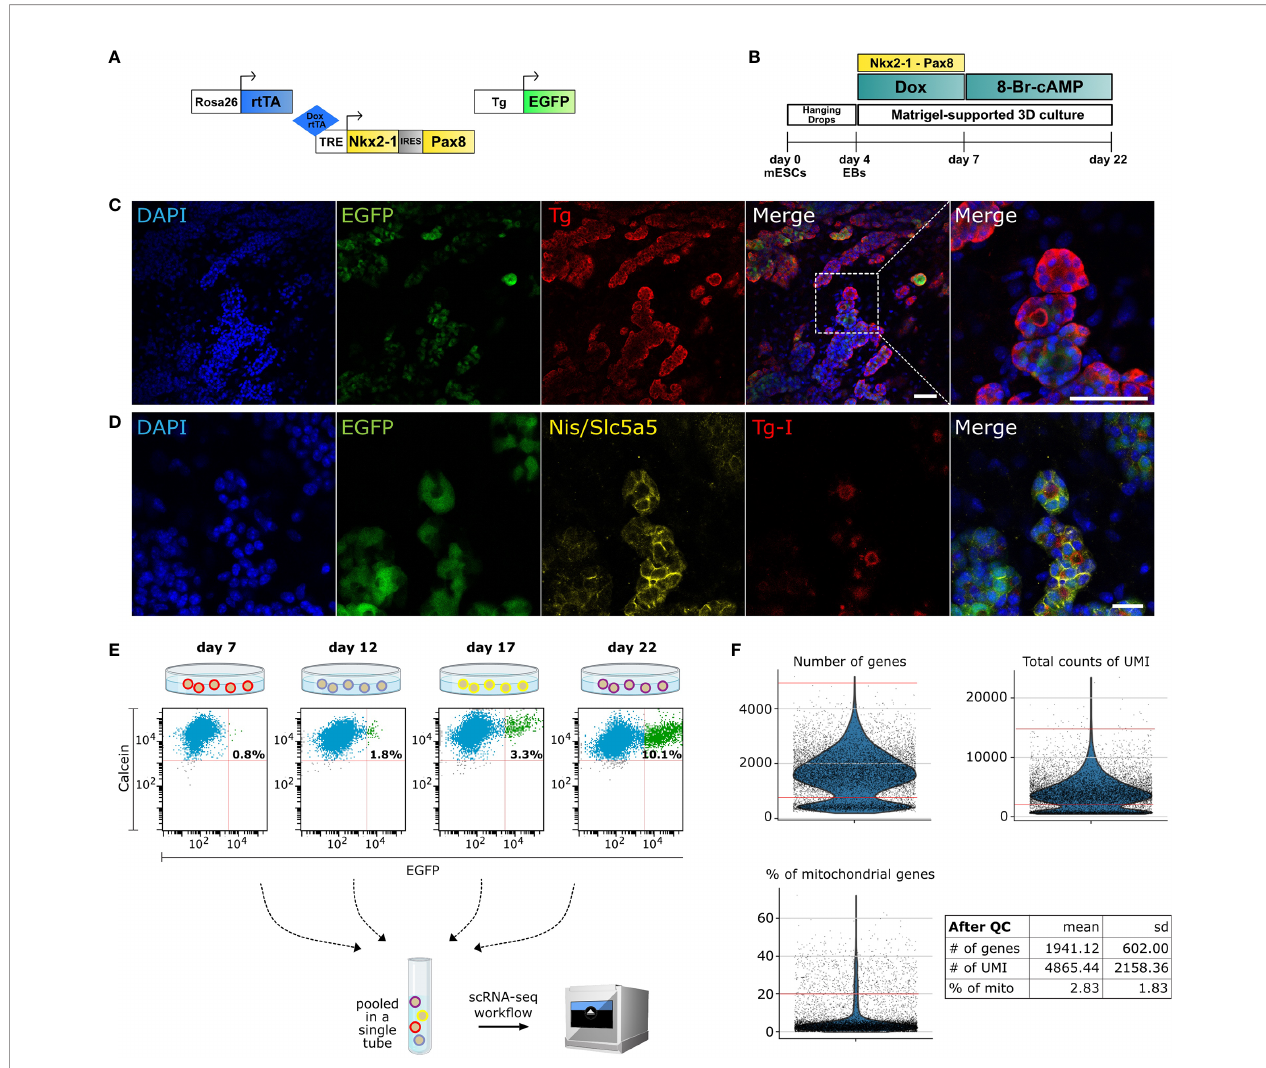
FIGURE 1 | Single-cell RNA-Seq of mouse organoid. (A) Schematic of the three constructs used in the protocol: Rosa26 locus driven reverse tetracycline-controlled transactivator (rtTA), Tet-Responsive Element (TRE) driven Nkx2-1 and Pax8 , and Tg promoter driven EGFP. (B) Schematic of differentiation protocol for mESC- derived in vitro thyroid organoid. (C) Immuno fl uorescence images from cells at day 22 displaying differentiated organoids marked with DAPI (blue), EGFP (green) and Thyroglobulin ( Tg ) (red). Zoomed image shows spheric thyroid follicles (Scale bars: 50 µm). (D) In addition, thyroid follicles express functional markers as Slc5a5/Nis (yellow) and Tg-I (red) (Scale bar: 20 µm). (E) Cells from differentiated organoids at days 7, 12, 17 and 22 were collected on the same day and labeled with calcein (live cell marker) and FACS-sorted for scRNA-seq analysis. Percentage of EGFP+ thyrocytes are noted. For downstream analysis, EGFP+ and EGFP- cells (1:1 ratio) from day 12, 17 and 22 (at day 7 no GFP+ enrichment was performed) were pooled into a single tube and sequenced using 10X Genomics platform. (F) Violin plots showing the quality control parameters for cells pro fi led using scRNA-seq. Number of genes, total counts of UMI and the percentage of mitochondrial genes were utilized for quality control. Red lines on violin plots depict the cutoffs for fi ltered cells. After fi ltration, cells from scRNA-seq had a mean ± standard deviation of 1941 ± 602 genes, 4865 ± 2158 UMIs and 2.83 ± 1.83% of mitochondrial gene